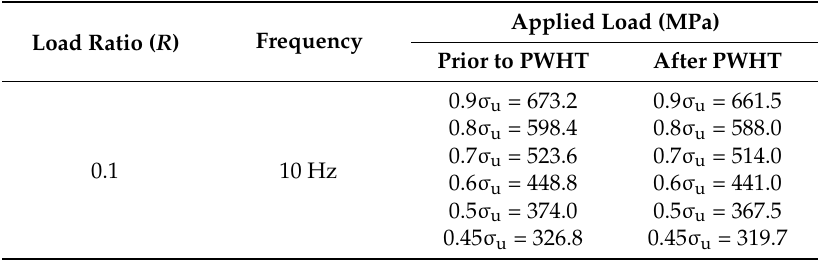
Table 6. Conditions of fatigue test in air.